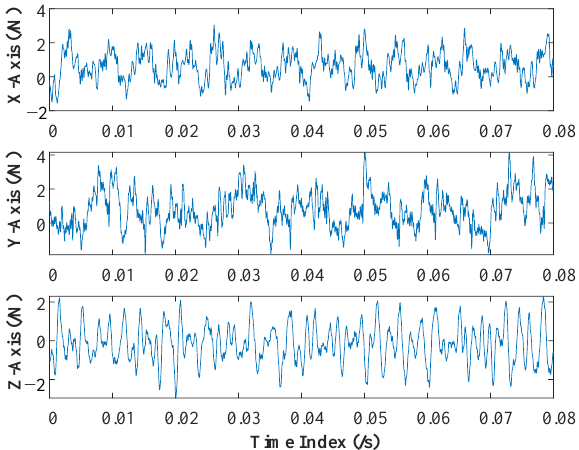
Figure 4. Time domain diagram of multivariate cutting force signals.